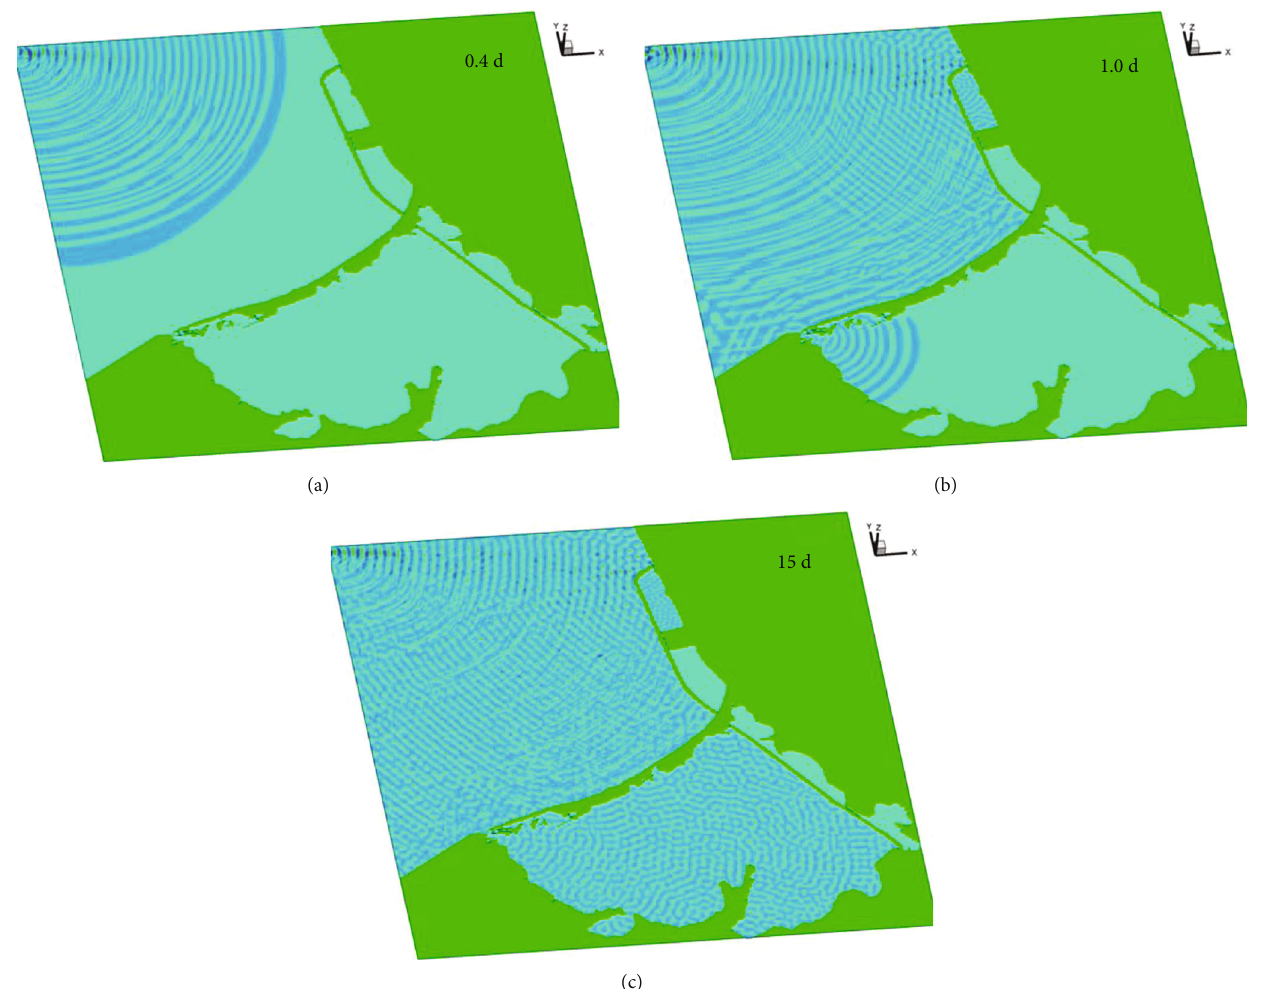
Figure 11: Development of wave propagation in the studied domain in normal conditions with landward roadway: (a) 0.4 day (9.6 hour) simulation. (b) One day simulation. (c) Fifteen days simulation.